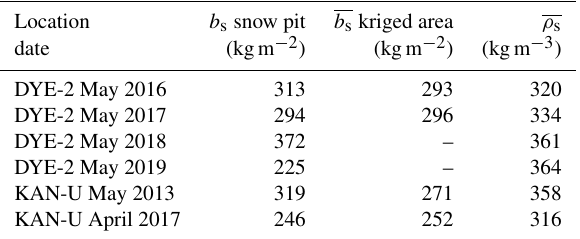
Table 4. Winter snow accumulation ( b s ) and snow density ( ρ s ) mea- sured in spring snow pits for DYE-2 and KAN-U compared with determined area-wide arithmetic